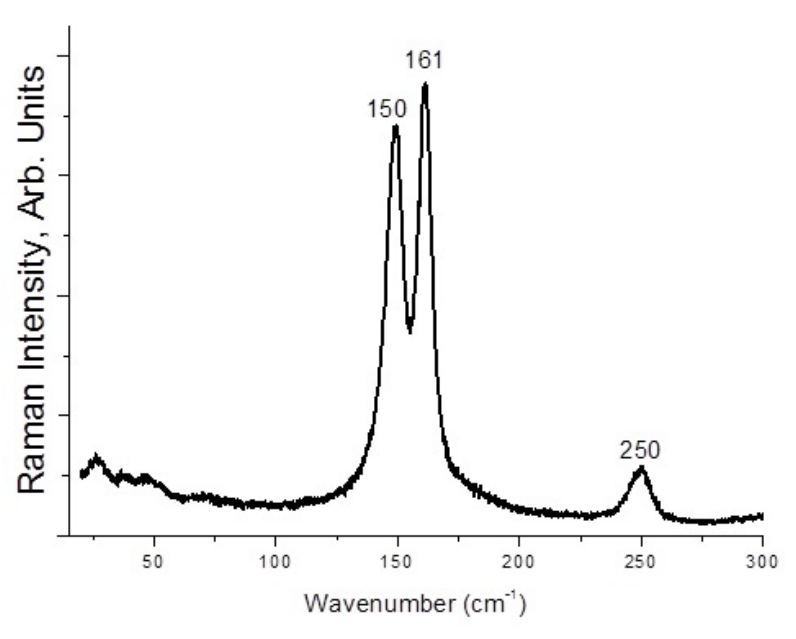
Figure 5. Raman spectrum of 1.